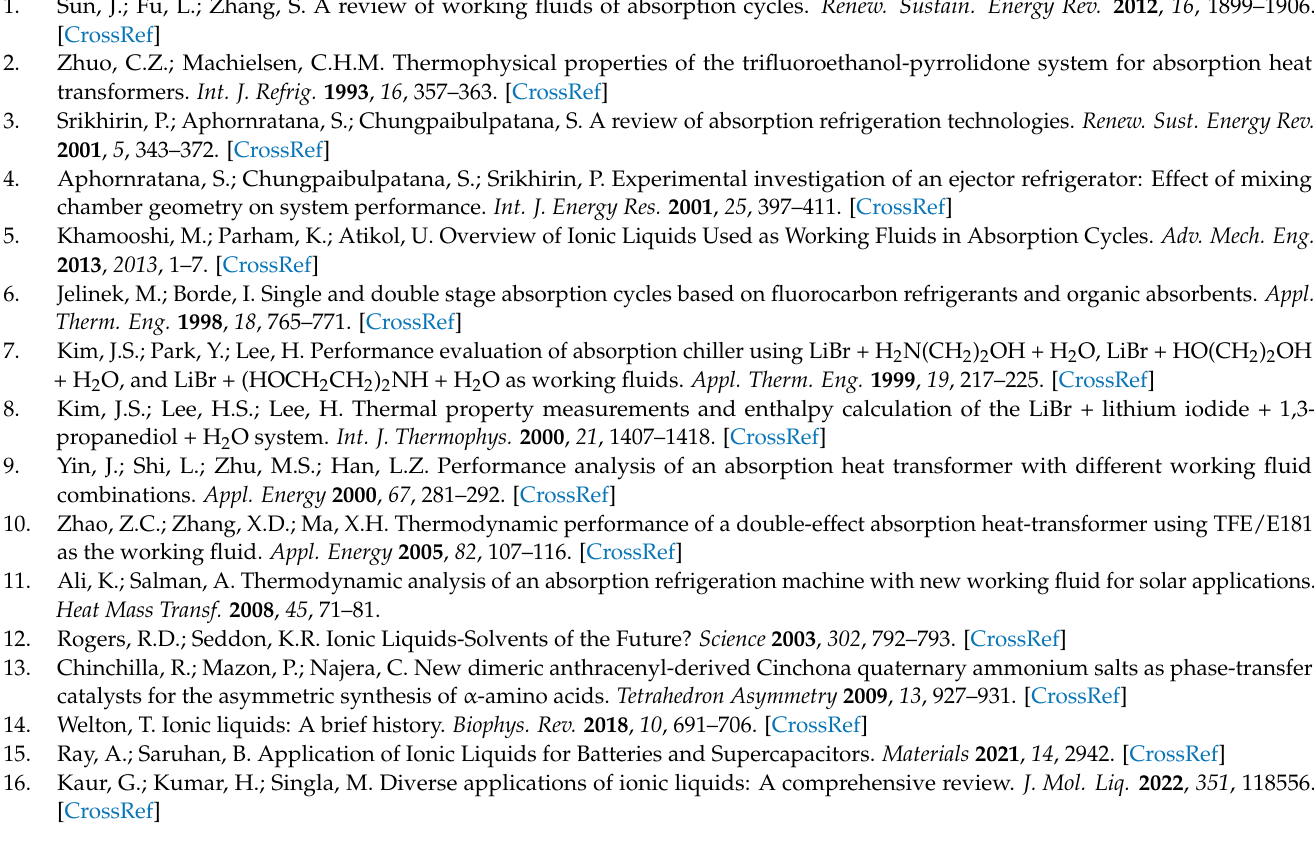
Figure S6. Experimental and calculated dynamic viscosity data for {[N1,2,2,2][DMP] (1) + Ethanol (2)} binary system as a function of (a) temperature for different IL mole fraction, x 1 : (cid:7) , 1.0000; (cid:7) , Points—experimental data; solid lines—correlation using Equation (19) with parameters fiven in Table 11. (b) Composition at different temperature, T: (cid:7) , 293.15 K; ♦ , 303.15 K; • , 313.15